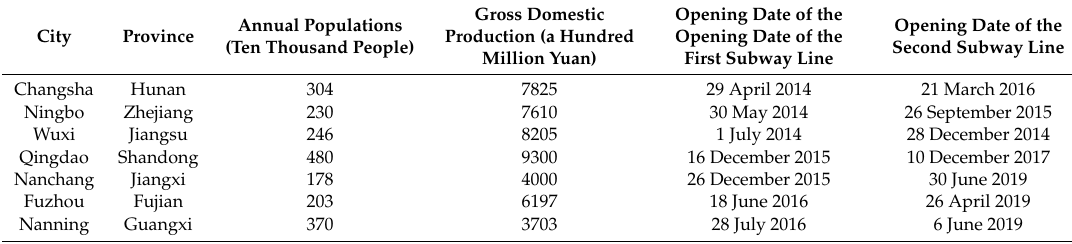
Table 3. The characteristics of the processing group.